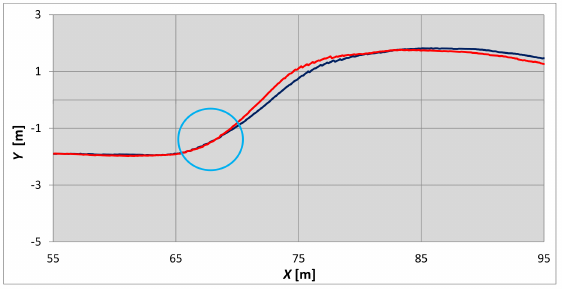
Figure 10. Change of the trajectory caused by resetting the rocker arm pin clearance (driving at ~40